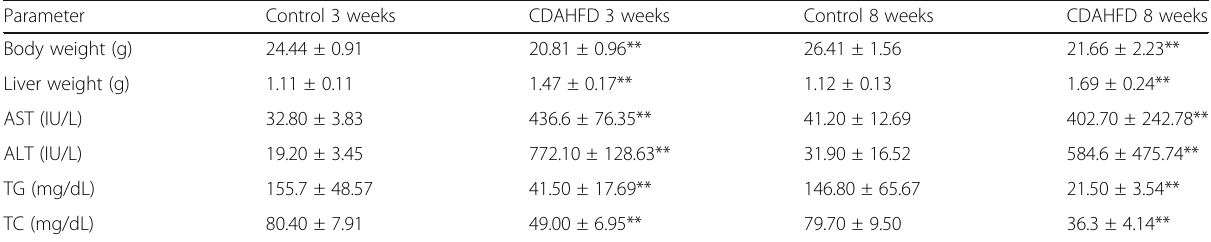
Table 1 Body, liver weight, and blood parameters in mice fed a CDAHFD Parameter